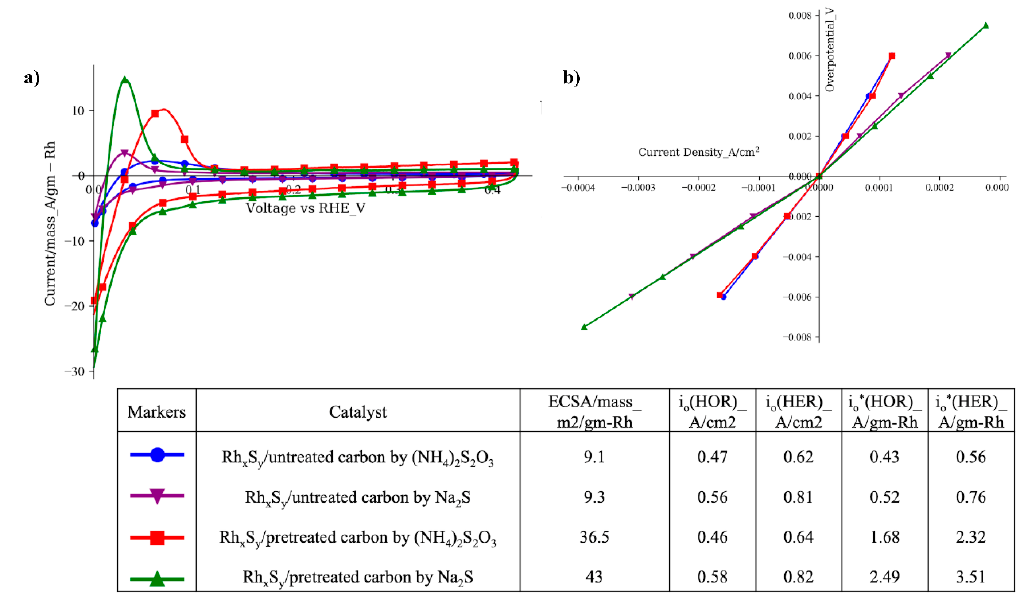
Figure 2. ( a ) Cyclic voltammograms of rhodium sulfide synthesized with di ff erent carbon substrates and sulfur sources (electrolyte: 1 M N 2 -saturated H 2 SO 4 solution; working electrode: catalyst-coated GDE; counter electrode: Pt foil, reference electrode: SCE; scan rate: 10 mV / s); ( b ) linear polarization curves of rhodium sulfide catalysts synthesized with di ff erent carbon substrates and sulfur sources (electrolyte: 1 M H 2 -saturated H 2 SO 4 solution; rotation speed: 2400 rpm; working electrode: catalyst-coated GC-RDE; counter electrode: Pt foil; reference electrode: SCE).